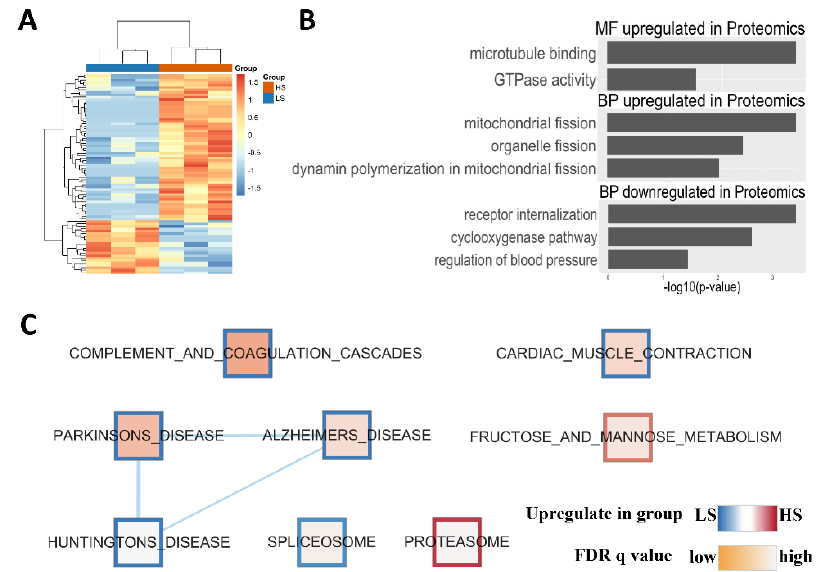
Figure 5. Gene Ontology (GO) and Gene Set Enrichment Analysis (GSEA) on dysregulated proteins identified by proteomics. ( A ) Heatmap of the proteome, where hierarchical clustering of samples (columns) and proteins (rows) is based on Pearson’s correlation coefficient to measure the distance and the mean to cluster the samples. ( B ) Gene Ontology (GO) analysis of 21 significantly downregulated and 59 significantly upregulated proteins. ( C ) Gene Set Enrichment Analysis (GSEA) of all detected proteins, where nodes represent significantly enriched ( p < 0.01, q < 0.05) gene sets of canonical pathways from the molecular signature database (MSigDB). The colors of node borders refer to upregulated (red) and downregulated (blue) in HS group, while the node color represents the FDR q -values